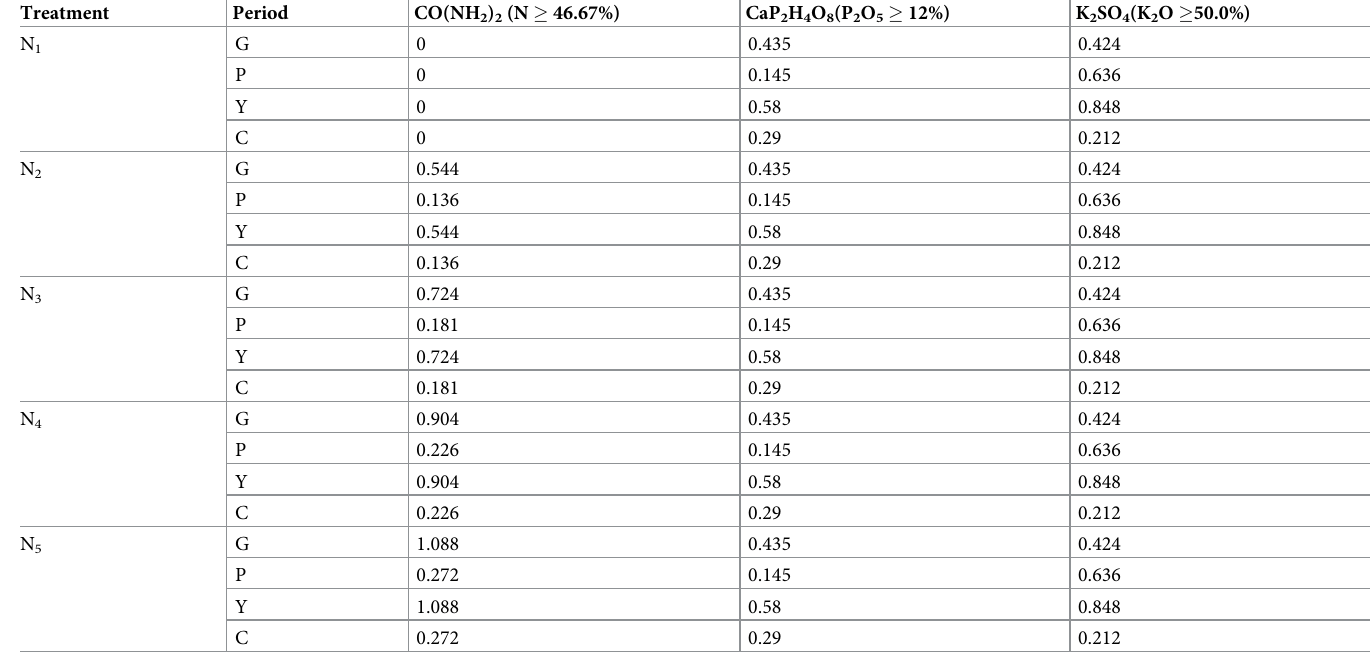
Fertilization was applied at four stages of development: germination (G); physiological fruit-dropping (P); young fruit expansion (Y) and fruit color-change (C); G:P:Y:C ratios were: 40:10:40:10 for CO(NH 2 ) 2 application, 30:10:40:20 for CaP 2 H 4 O 8 application, and 20:30:40:10 for K 2 SO 4 application. Nicotiana benthamiana seeds were germinated in small pots filled with peat moss and grown under controlled conditions at 25˚C, 60–70% RH, 4000 lux, and a 14/10 h light/dark regime for 6 weeks.